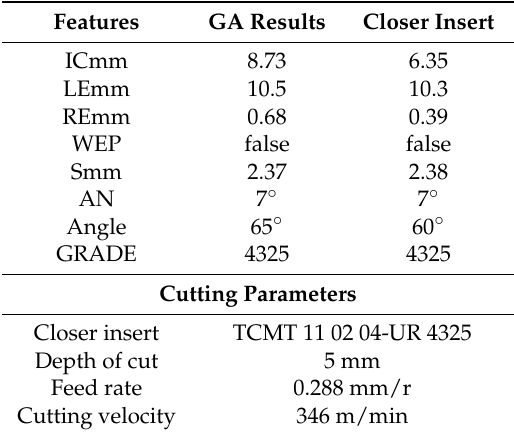
Figure 12. Example of GA performance for light roughing operation. Table 10. Results of the light roughing operation example.